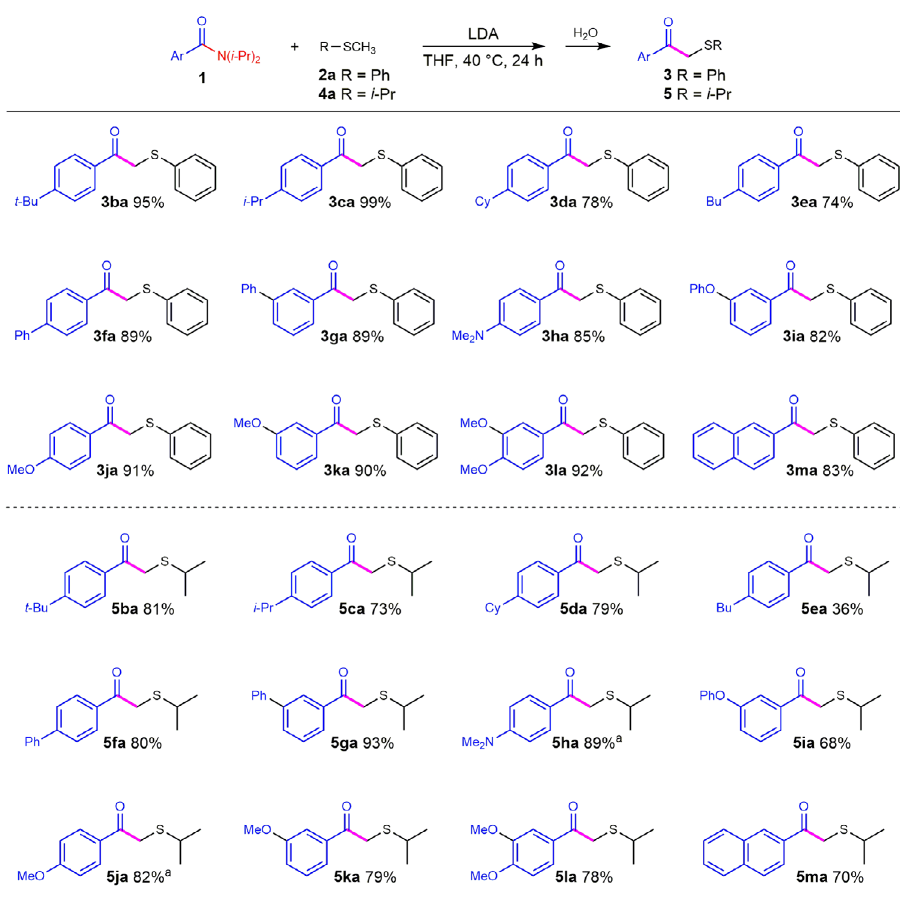
Fig. 3 Scope of Benzamides. Conditions: for thioanisole, benzamide 1 (0.5 mmol), 2a (0.7 mmol), LDA (0.55 mmol), THF (1 mL), 40 °C, 24 h; for isopropyl methyl sul fi de, benzamide 1 (0.5 mmol), 4a (1.25 mmol), LDA (0.75 mmol), THF (1 mL), 40 °C, 24 h. a 60